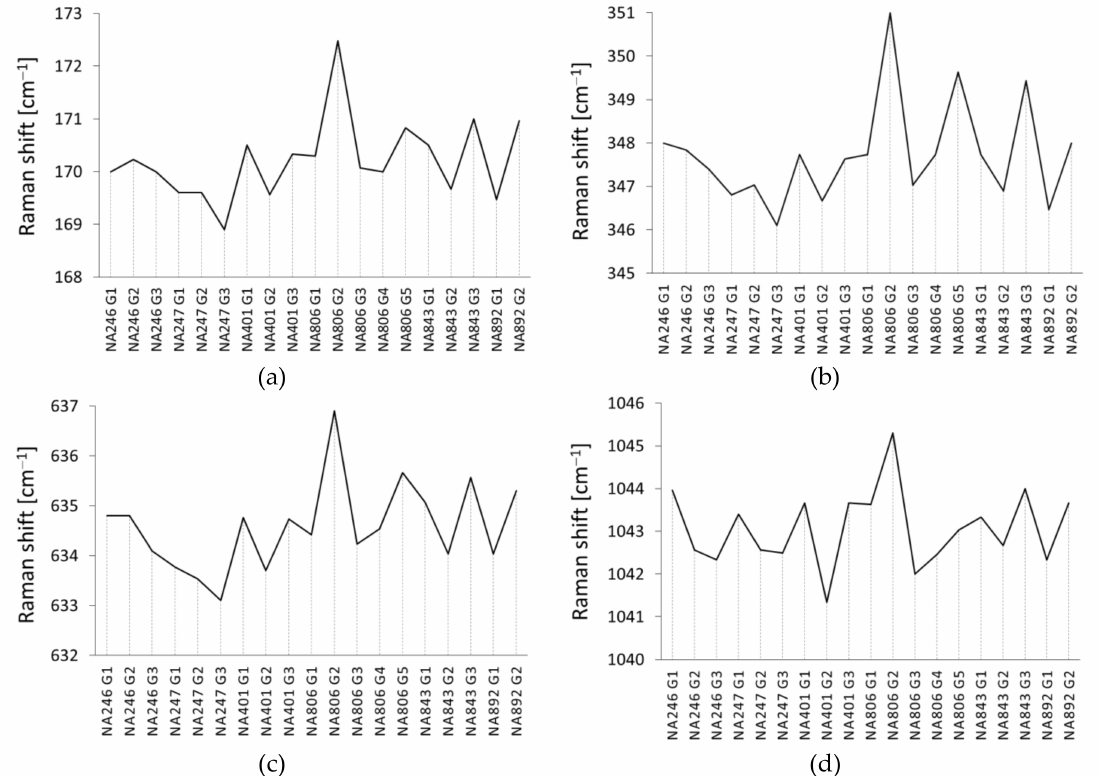
Figure 7. Selected Raman mode frequencies change ( a ) Raman shifts for translation mode of the X 2 +